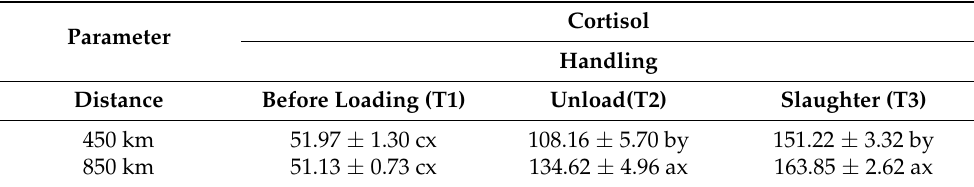
Table 6. Cortisol, as influenced by the interaction between handling and distances in Brahman crossbred